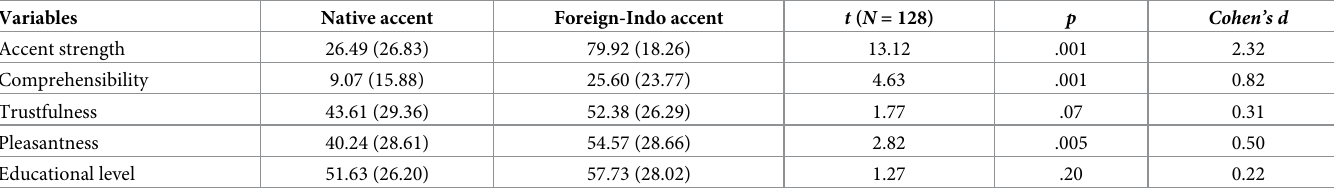
Table 1. Results of the perception of the native and foreign-Indo accent on a number of linguistic and social variables (0–100). Variables